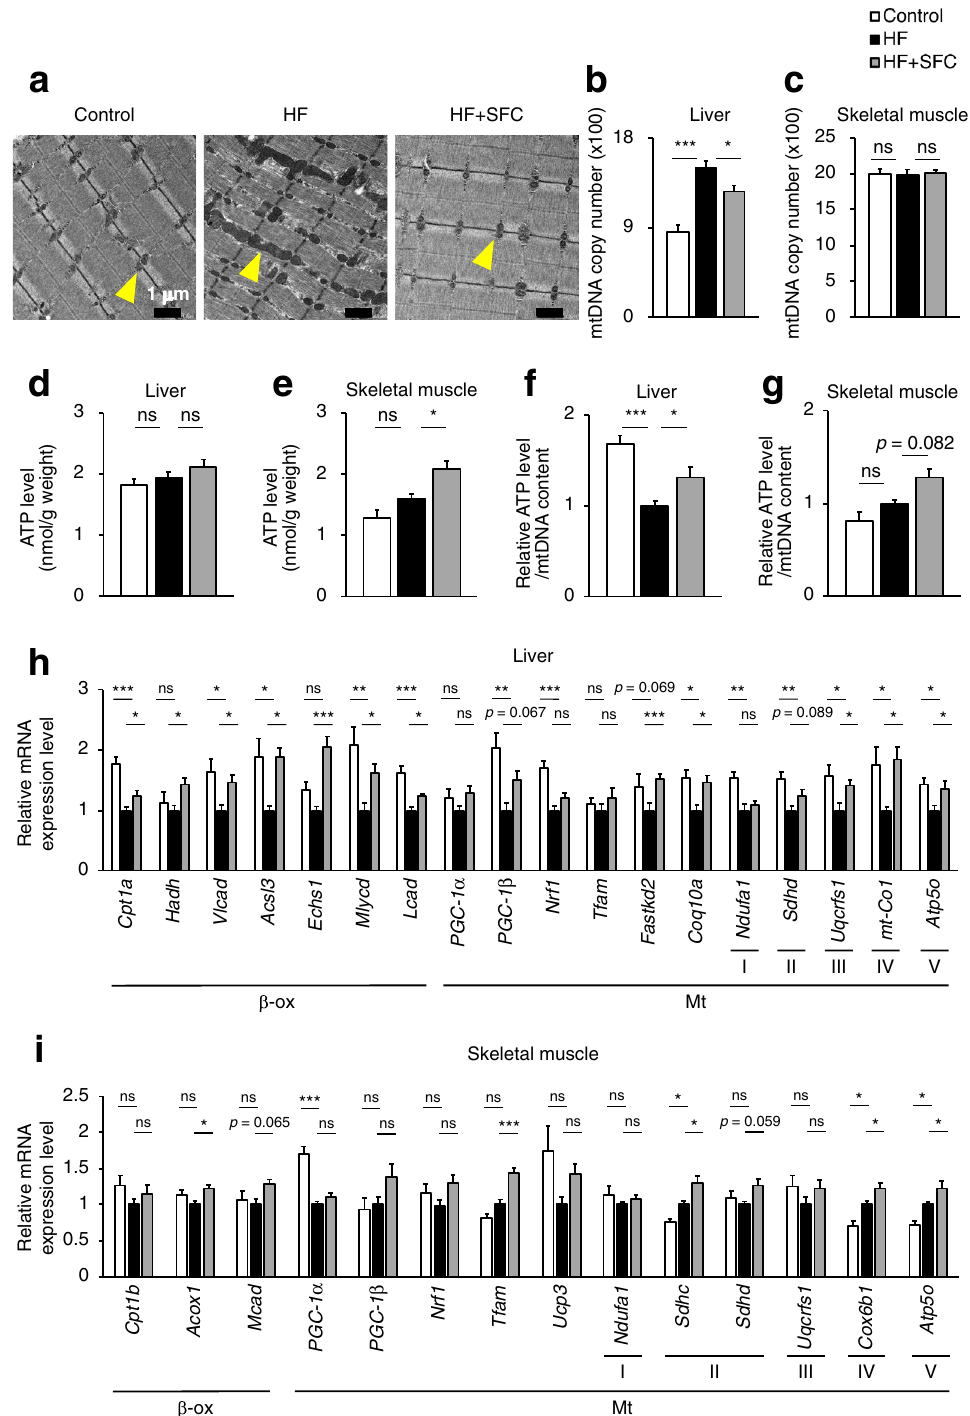
Figure 5. Iron supplementation reduces mitochondrial morphological abnormalities and increases mitochondrial- associated gene expression. ( a – i ) Male C57BL/6J mice of 6 weeks of age were fed with each diet for 15 weeks as specified in Fig. 1. ( a ) Representative image of transmission electron microscopy analysis in skeletal muscle. Yellow arrows point to the mitochondria. Scale bar is 1 μm. ( b , c ) Copy number of mitochondrial DNA (mtDNA) in ( b ) liver and ( c ) skeletal muscle ( n = 5–6). ( d , e ) ATP levels normalized by tissue weight in ( d ) liver and ( e ) skeletal muscle ( n = 5–6). ( f , g ) ATP levels normalized by mtDNA in ( f ) liver and ( g ) skeletal muscle ( n = 5–6). ( h , i ) Analysis of mRNA expression related to fatty acid beta oxidation (β-ox), mitochondrial (Mt), mitochondrial respiratory chain complex I (I), II (II), III (III), IV (IV), and V (V) in ( h ) liver; and ( i ) skeletal muscle ( n = 5–6). Data are expresses as mean ± SEM values. Statistical analysis was performed using a one-way ANOVA followed by Holm–Sidak’s post hoc test. * p < 0.05; ** p < 0.01; *** p < 0.001; ns, not significant. (Significant differences vs.